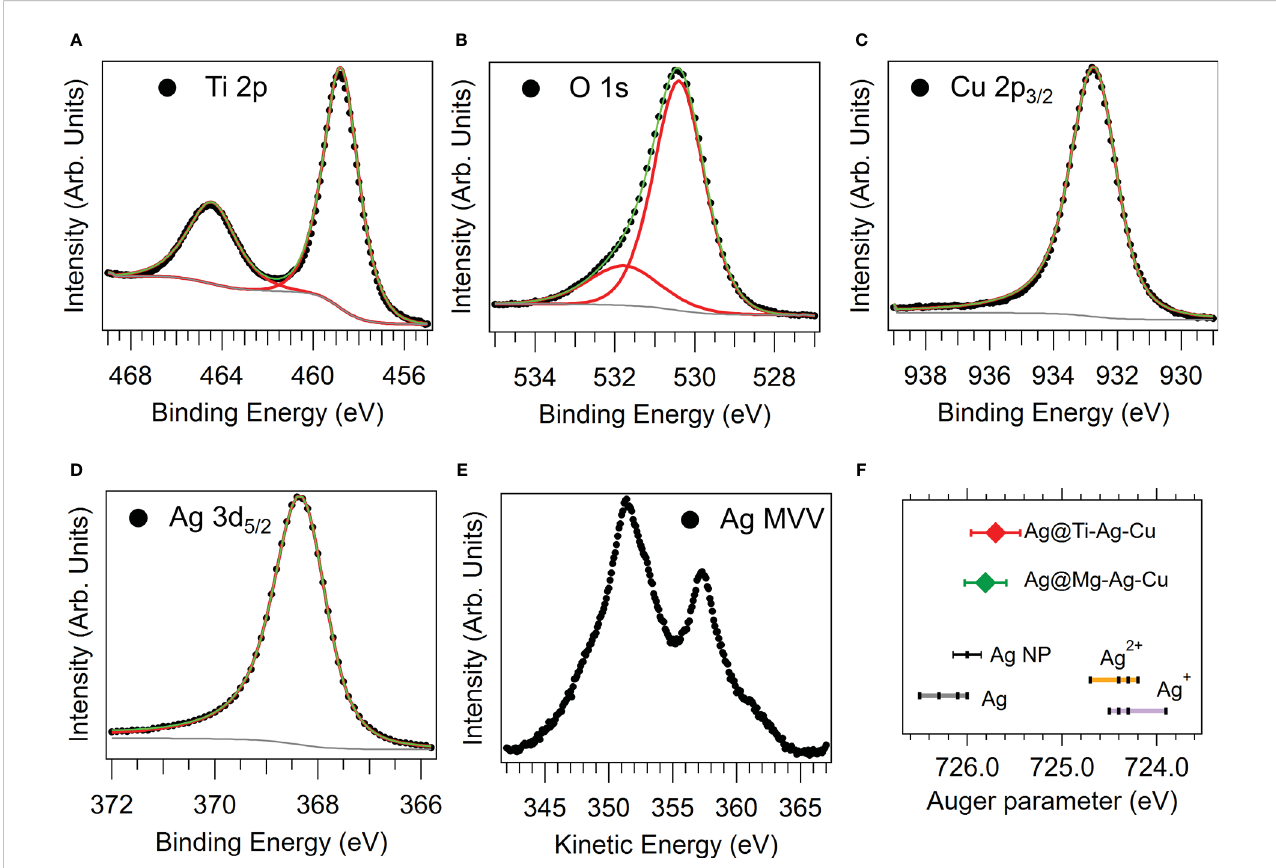
FIGURE 2 Spectroscopic characterization of the Ti-Ag-Cu sample. (A) Ti 2p, (B) O1s, (C) Cu 2p (only the 2p 3/2 component is shown), (D) Ag 3d (only the 3d 5/2 component is shown), and (E) Ag MVV Auger emission spectra. (F) Scheme of the Auger parameters obtained for the Ti-Ag-Cu (red diamond) and Mg-Ag-Cu (green diamond)